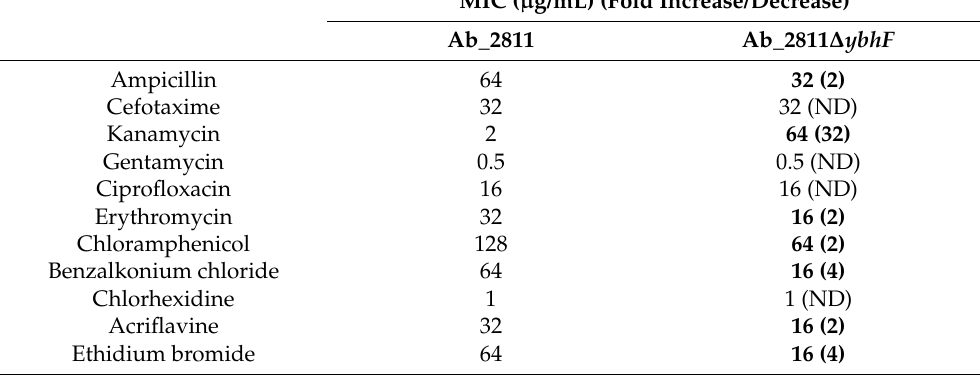
Table 1. Minimum inhibitory concentration, in µ g/mL, of several antibiotic classes, disinfectants, germicide, and substrates of efflux pumps for the parental and derived mutant Aliarcobacter butzleri strains.